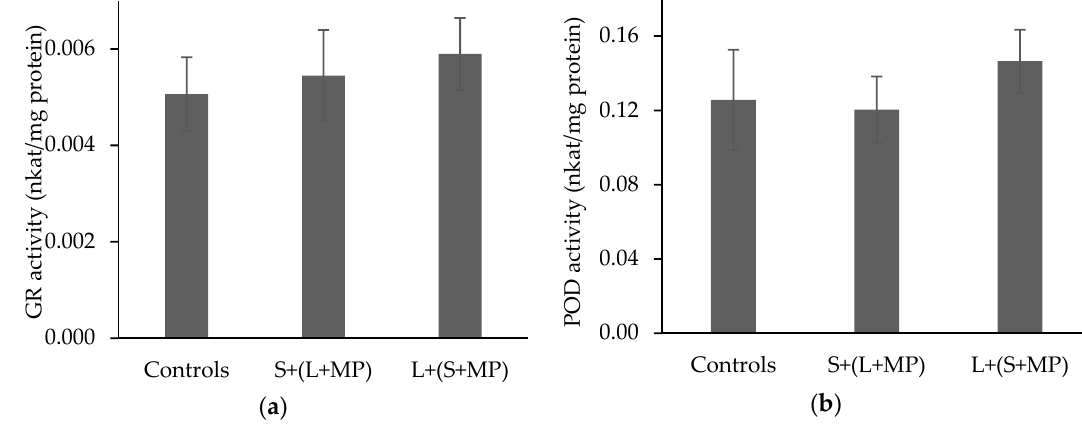
Figure 2. Peroxidase ( a ) and glutathione reductase ( b ) activities in T. tubifex exposed to fluorescent polyethylene (PE) microspheres through the media (S + (L + MP)) and the sediment (L + (S + MP). Values are expressed as mean enzyme activity ± standard error (n = 5). * denotes significance compared to the control ( p < 0.05).